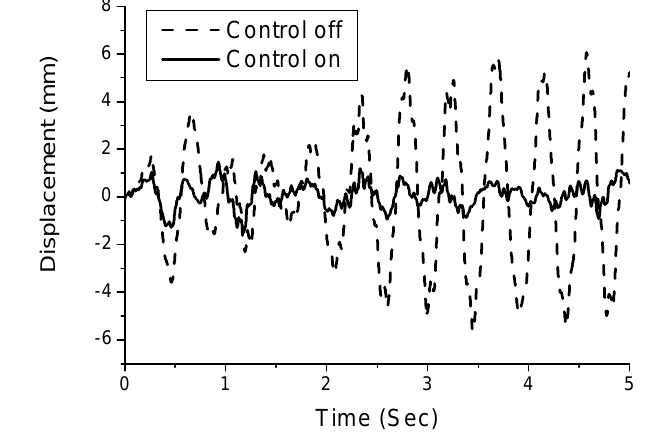
Fig. 8. Displacement response to random